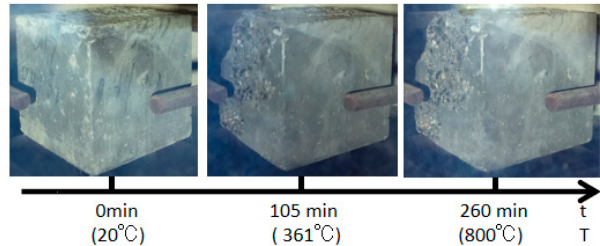
Figure 14. The explosion process of the 150-mm PVA specimens.